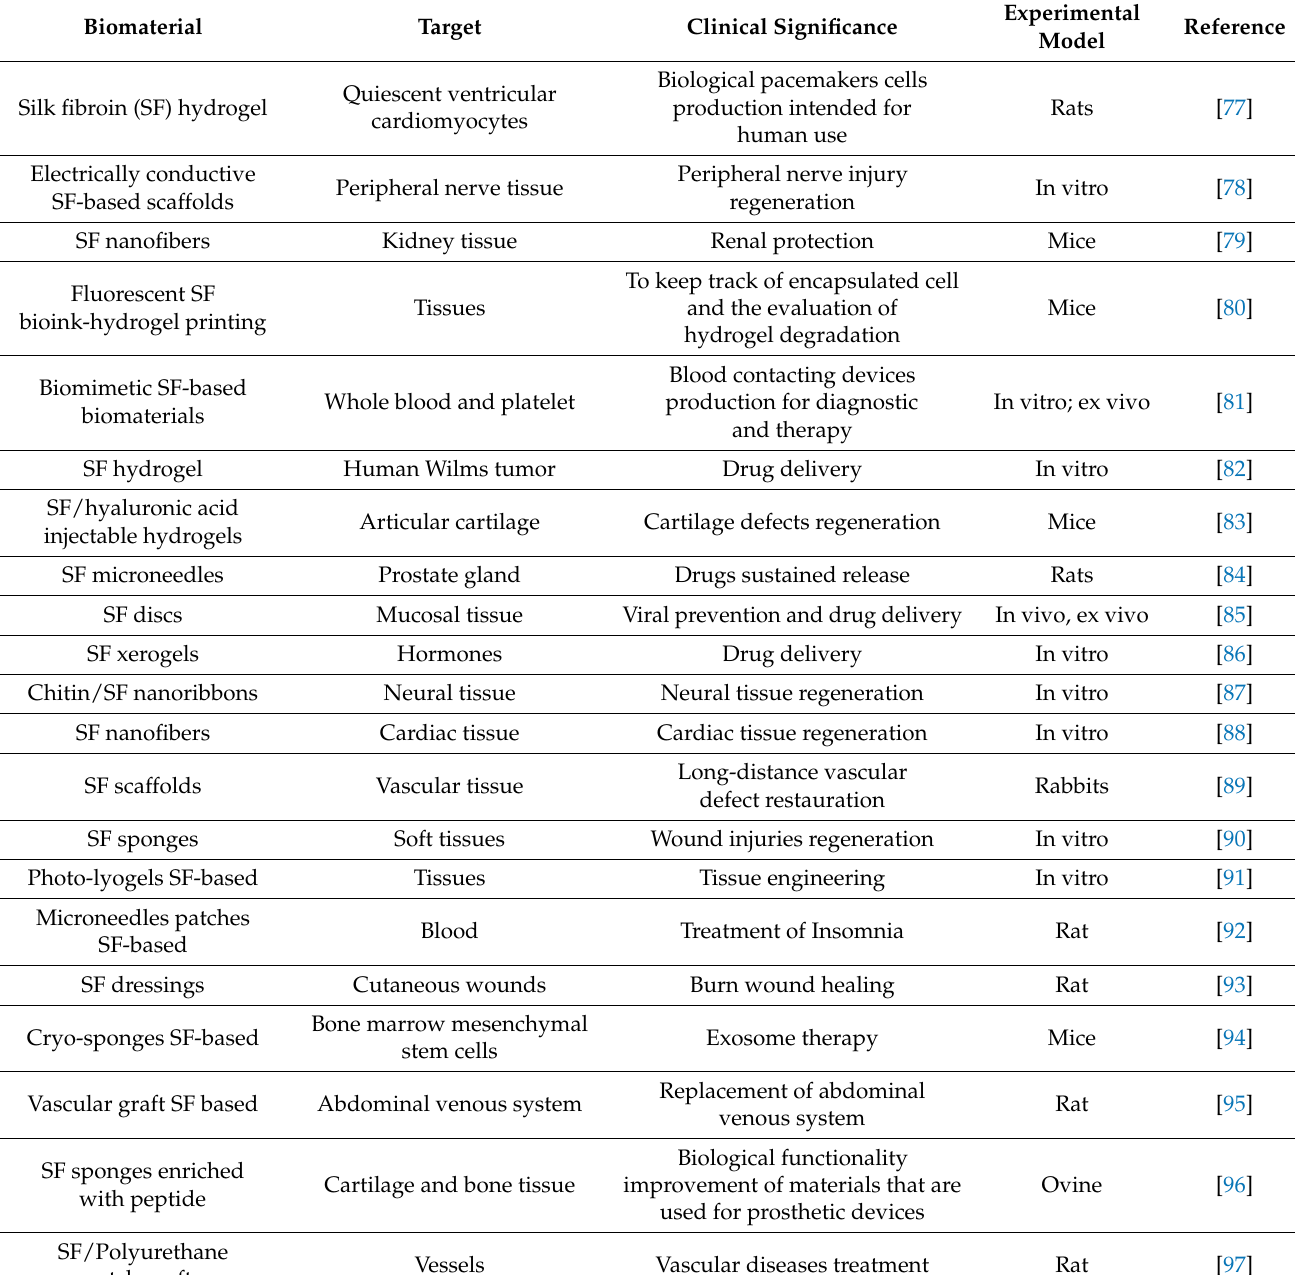
Table 1. Clinically significant silk-based